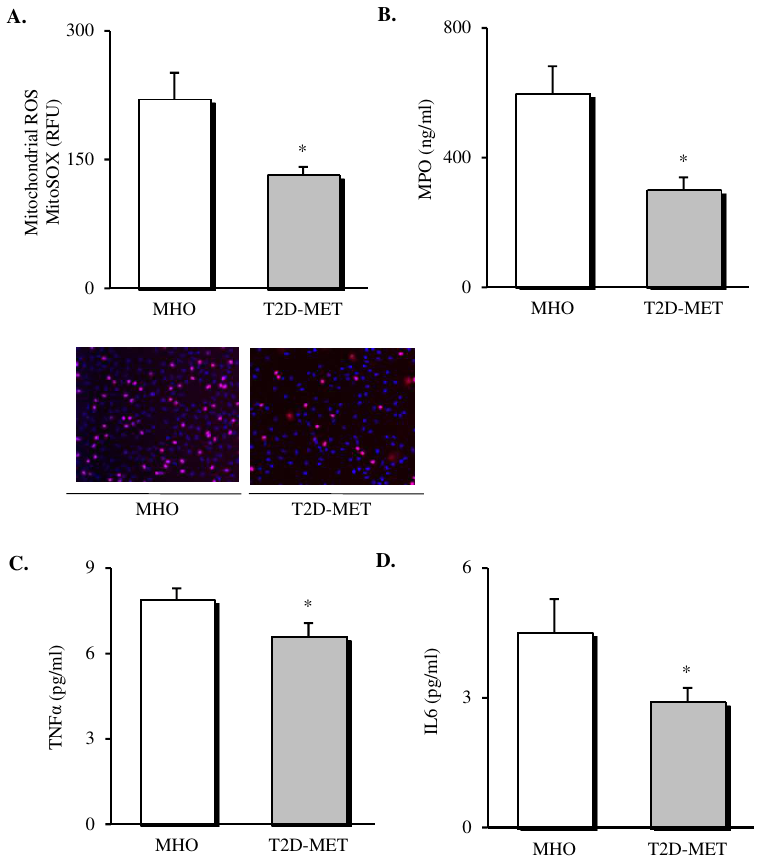
Figure 1. Evaluation of systemic oxidative stress markers and cytokines in the serum of MHO and obese T2D patients treated with metformin. Levels of mitochondrial ROS production ( A ) expressed as arbitrary units and the representative images of their leukocytes stained with MitoSox (red) and Hoechst 33,342 (blue) and visualized by fluorescence microscopy ( n = 20 in MHO and n = 17 in T2D-Met), serum levels of ( B ) MPO ( n = 11 in MHO and n = 16 in T2D-Met), ( C ) TNF α ( n = 14 in MHO and n = 15 in T2D-Met) and ( D ) IL6 ( n = 12 in MHO and n = 15 in T2D-Met). Data are expressed as mean + standard error. * p < 0.05 when compared using unpaired Student’s t -test. ROS, reactive oxygen species; RFU, relative fluorescence units; MPO, myeloperoxidase; IL6, interleukin 6; TNF α , tumor necrosis factor alpha; MHO, metabolically healthy obese; T2D-Met, type 2 diabetic patients treated with